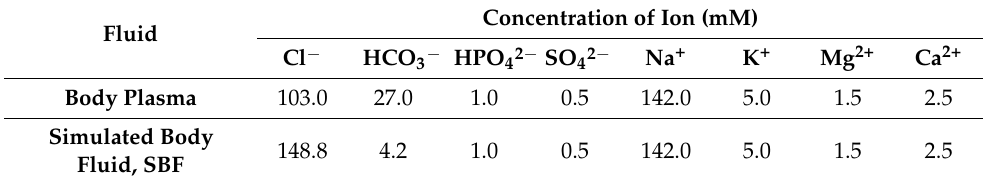
Table 1. Chemical composition of simulated body fluid (SBF) and body plasma (pH = 7.4) [25,40].